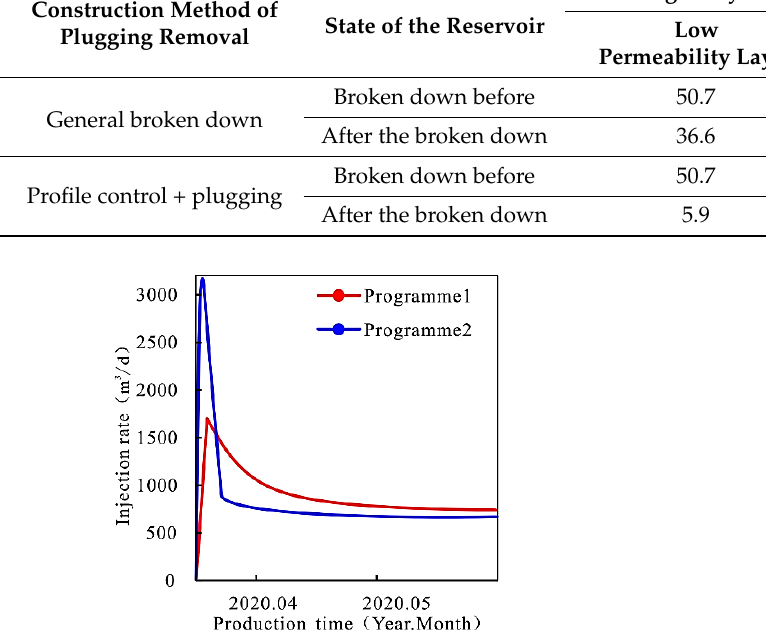
Figure 10. Relationship between injection speed and time.